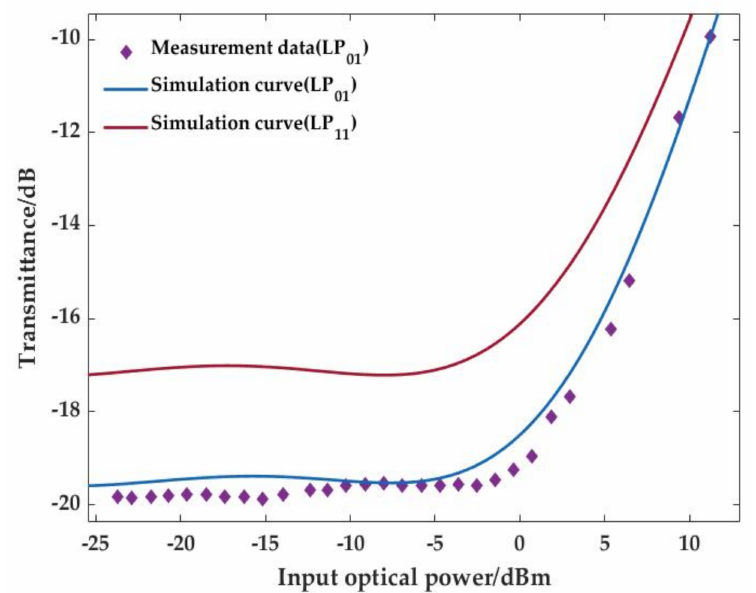
Figure 4. Measured and simulated transmission